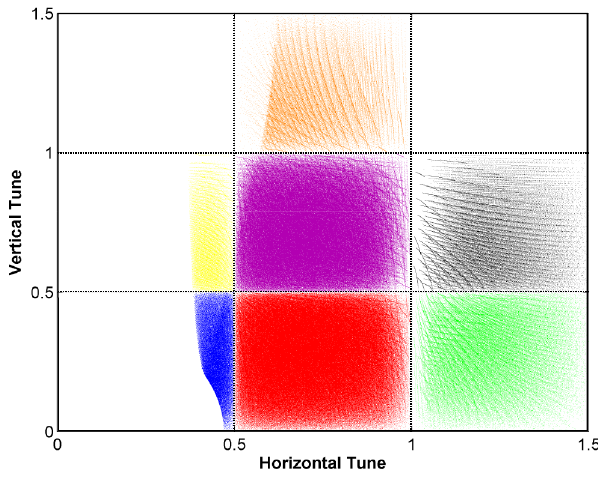
FIG. 12. (Color) Using different colors to illustrate how the different regions in tune space for one of the four CAMD DBA sectors correspond with the different regions in k -space. Each of the 0 : 5 (cid:7) 0 : 5 regions in tune space is given a distinct